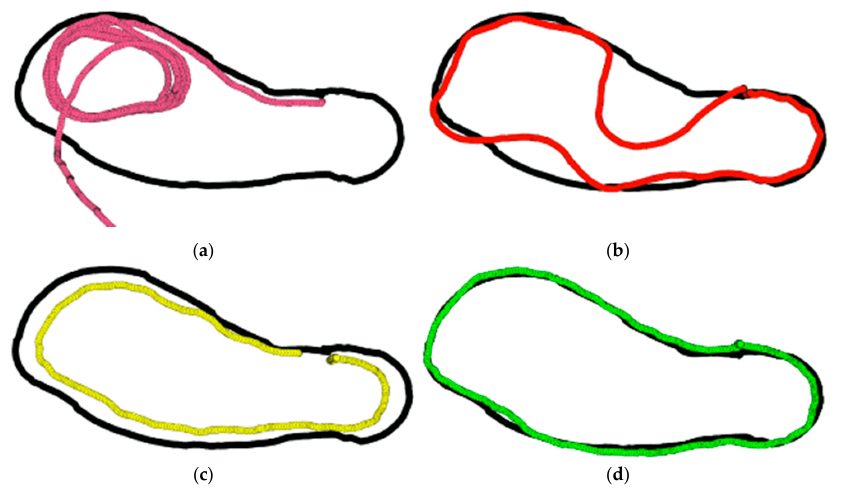
Figure 14. Performance of the rover when the ( a ) ROS updates were high (10 Hz), ( b ) Short look ahead distance (1 m), ( c ) no path error correction was applied and ( d ) successful path tracking when look-ahead was 3 m, K was 1.5, and ROS updates were at 1 Hz. Blacklines are the predefined waypoints, while colored lines represent the rover passes for each condition from 1 to 4.